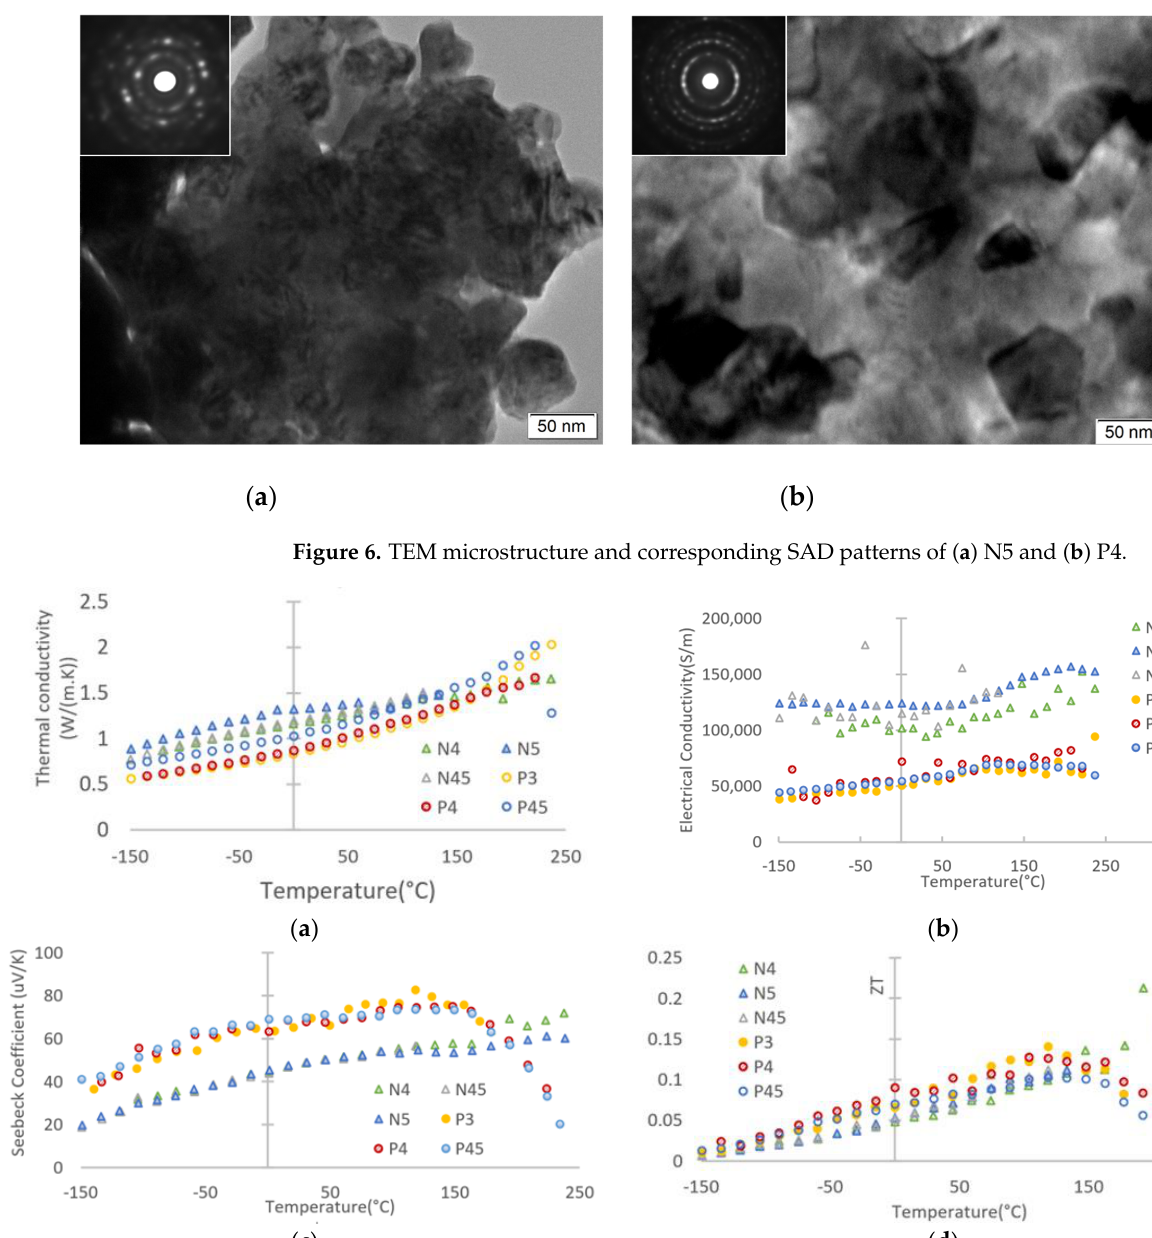
Figure 5. XRD comparison of different N-type and P-type layers on silicon substrate.